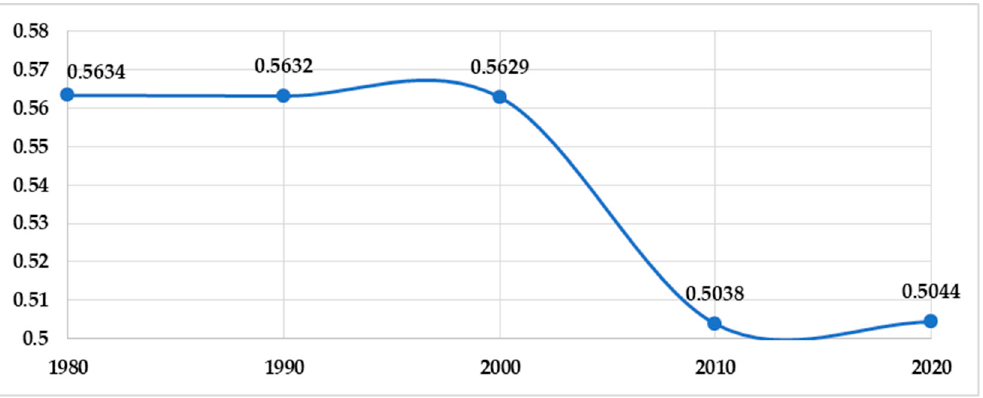
Figure 9. Change trend of EEQI.